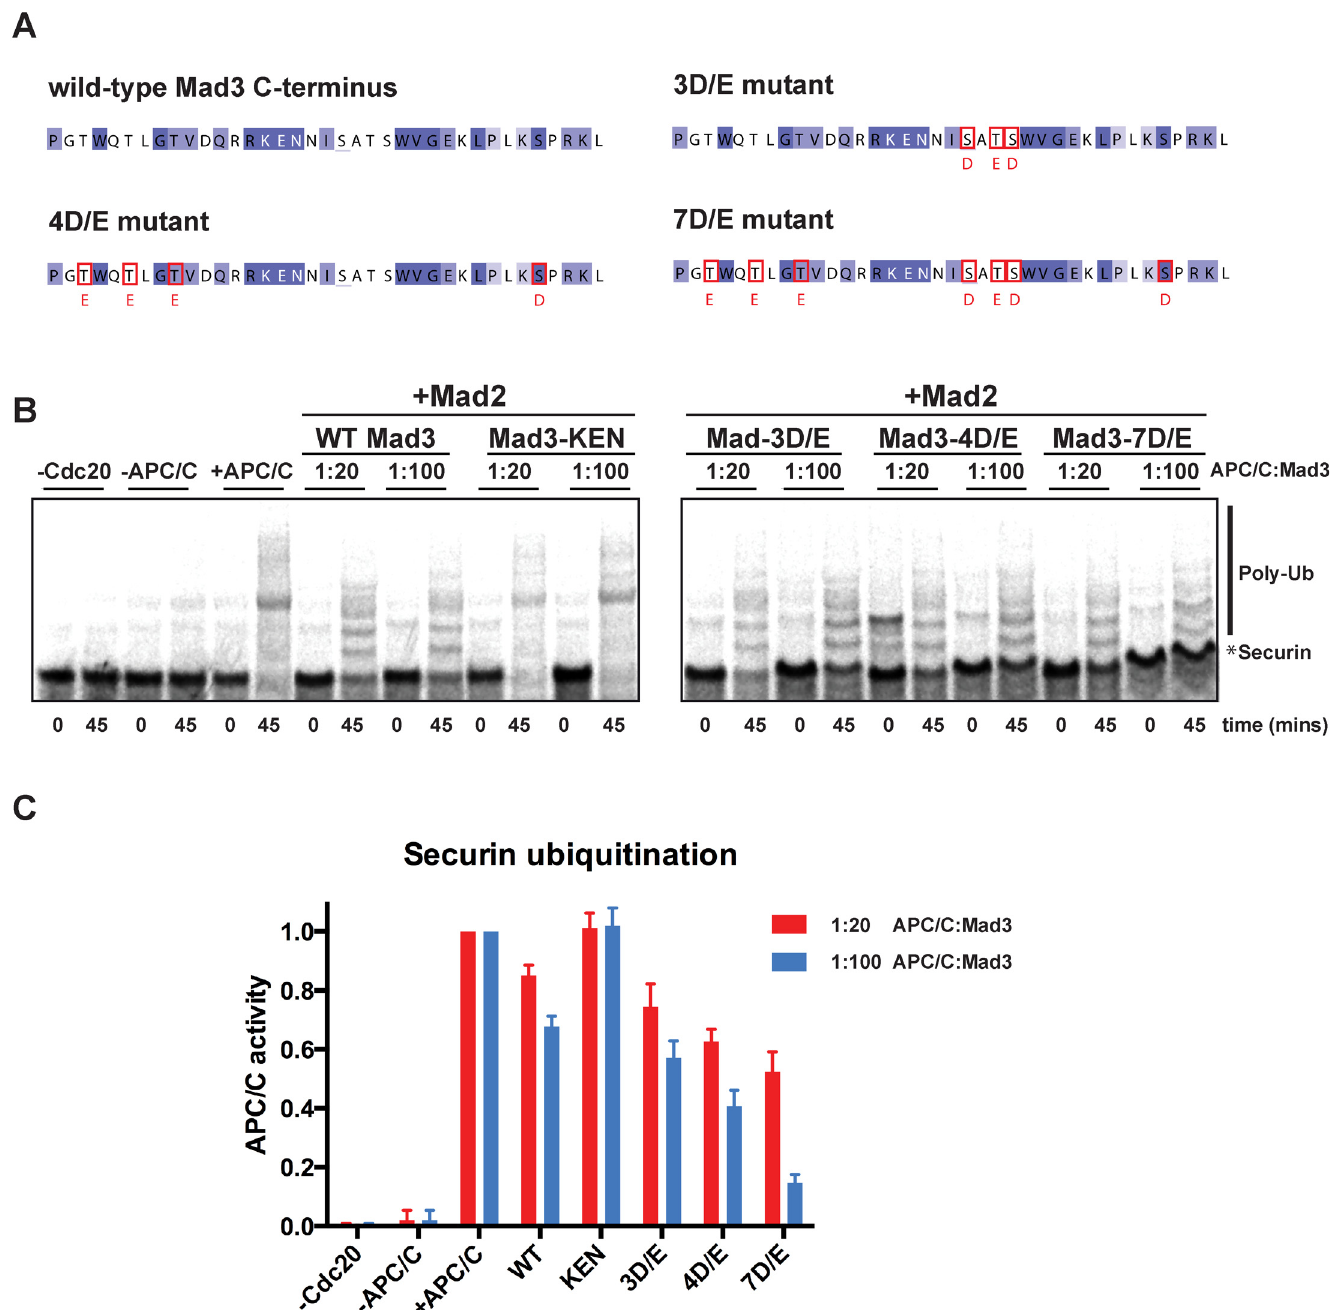
Fig 6. Mad3p modification directly affects its ability to inhibit APC/C activity. A. Mad3p C-terminal sequence highlighting the residues mutated in the 3, 4 and 7D/E mutants. B. Fission yeast APC/C in vitro activity reactions showing the ubiquitination of securin Cut2 . Half of each reaction (10 μ l) was taken immediately after mixing all the components and added to 4xSDS gel buffer (0 min). The remaining 10 μ l were incubated at 23°C for 45 min. Control reactions, one lacking the activator Cdc20 Slp1 (-Cdc20), one lacking the APC/C (-APC/C) and one containing both Cdc20 Slp1 and APC/C (+APC/C), are shown together with wild-type Mad3p (WT), the double KEN box mutant ( mad3-KEN1 , 2-AAA) and the corresponding phospho-mimic mutants at 1:20 and 1:100 APC/C:Mad3p molar ratios respectively. Purified cMad2p was added at 1:12.5 APC/C:Mad2p molar ratio in all reactions. A phosphoimager and Imagequant software were used to quantify the amount of radioactivity left in the un-modified securin band ( * ). C. Quantification of APC/C inhibition by wild- type (WT) Mad3p and mutants. Results from three independent experiments were combined and plotted (as mean with SEM). Data were normalised against APC/C activity containing no Mad2p or Mad3p